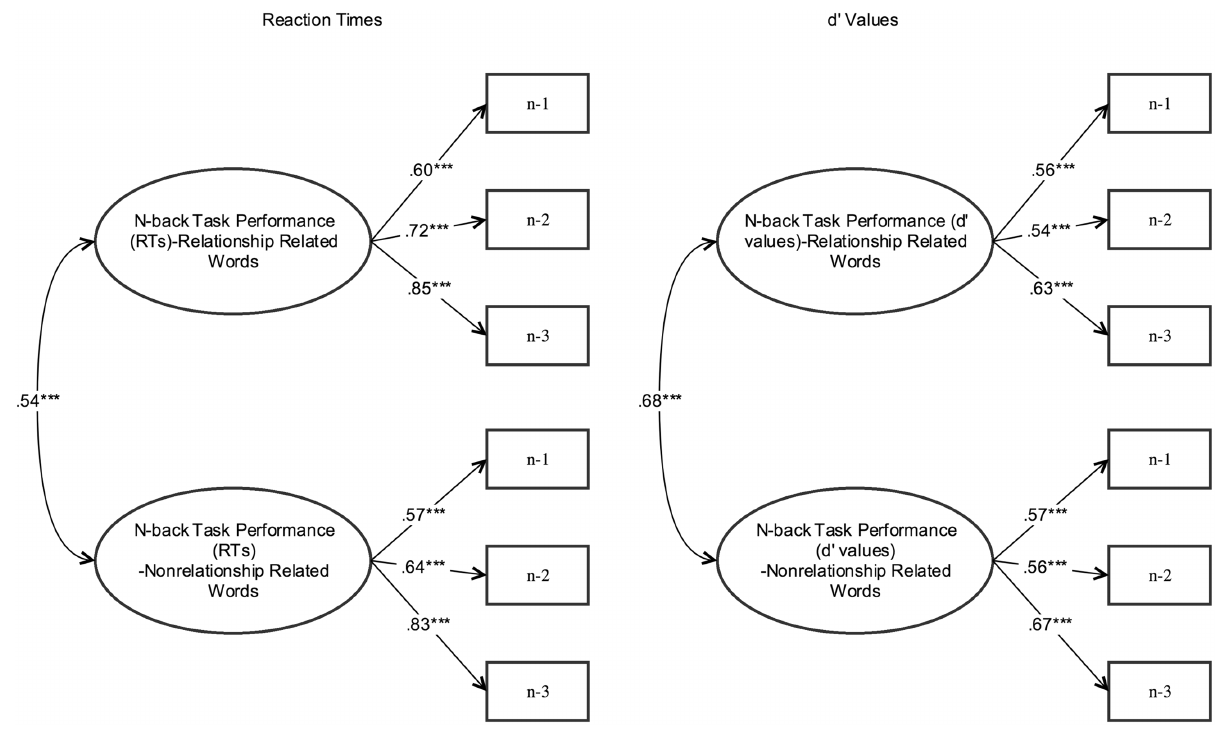
Fig 2. Measurement model estimations for the n-back task